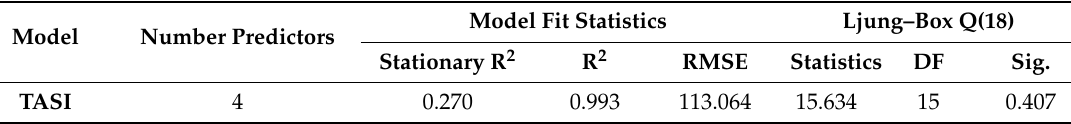
Table 5. Ljung–Box test for ARIMA model.